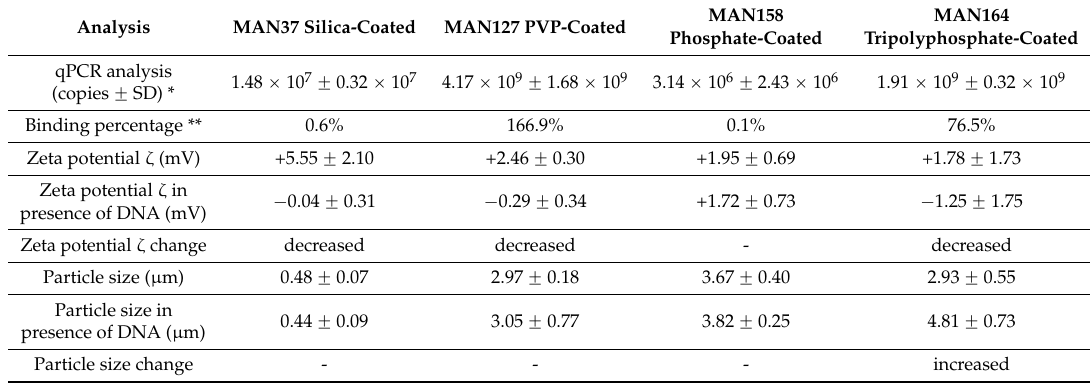
Table 1. Summary of results: quantitative PCR, zeta potential, and particle size.